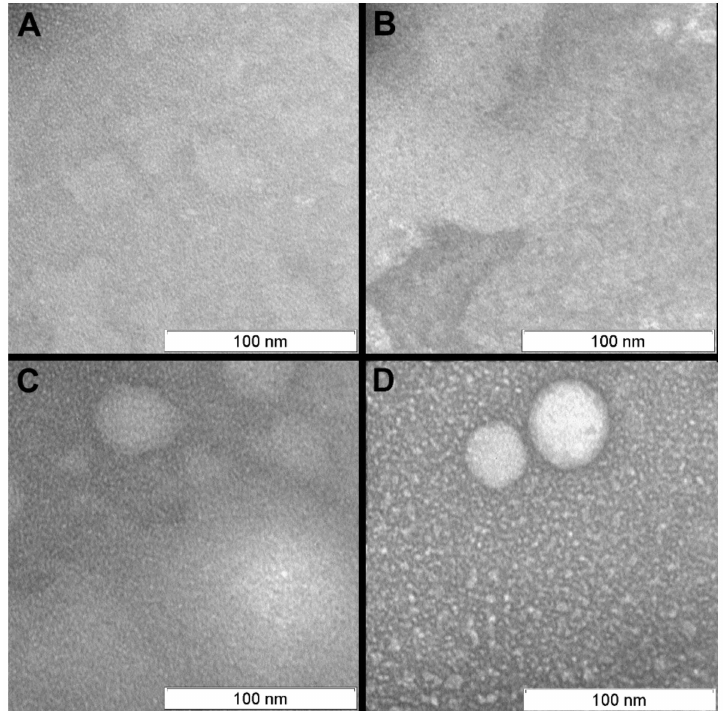
Figure 7. Background of the transmission electron microscopy (TEM) pictures (area between virions). ( A ) Purified virus suspension; ( B ) Light control; ( C ) Dark control; ( D ) After photodynamic inactivated (4 µ M photosensitizer, 20 min). Scale bar 100